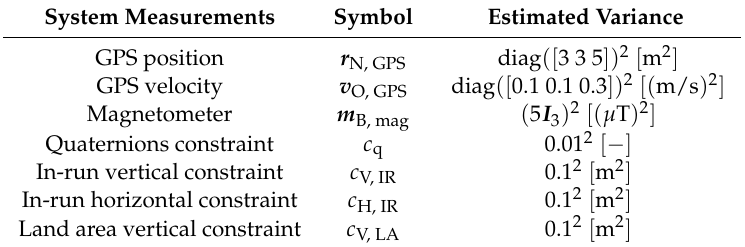
Table 5. Diagonal elements of the estimated measurement noise covariance matrix R